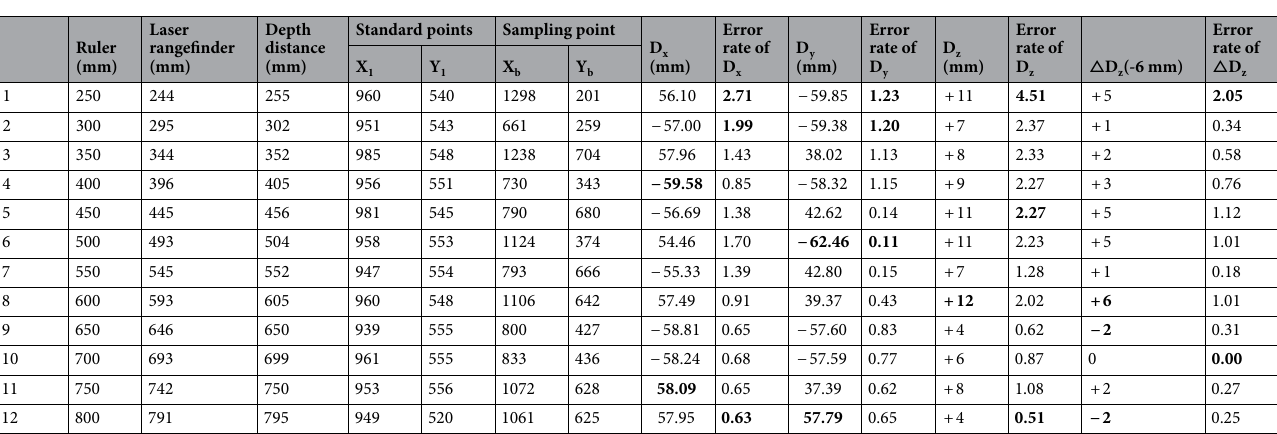
Table 2. 3D distance experiment: indoor. Significant values are in